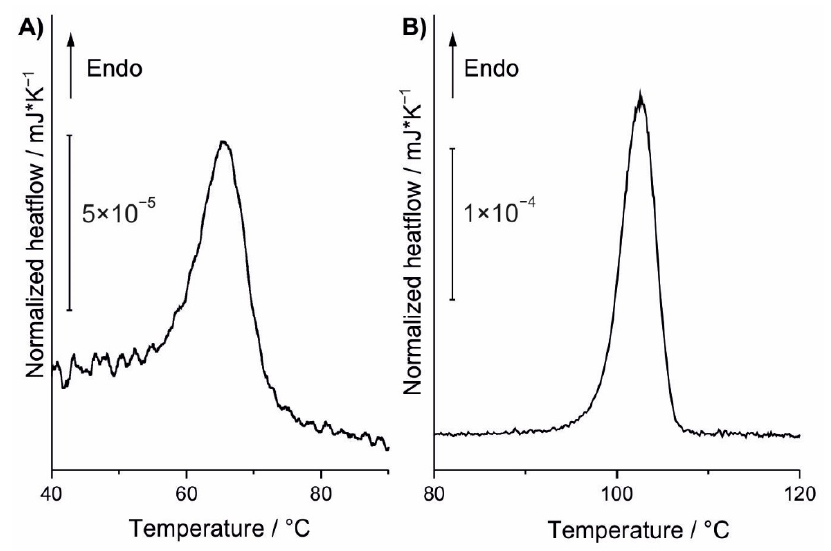
Figure 7. Heating scans of compound 4 ( A ) and compound 5 ( B ) crystallized on the chip-sensor. 100 K / s heating rate.